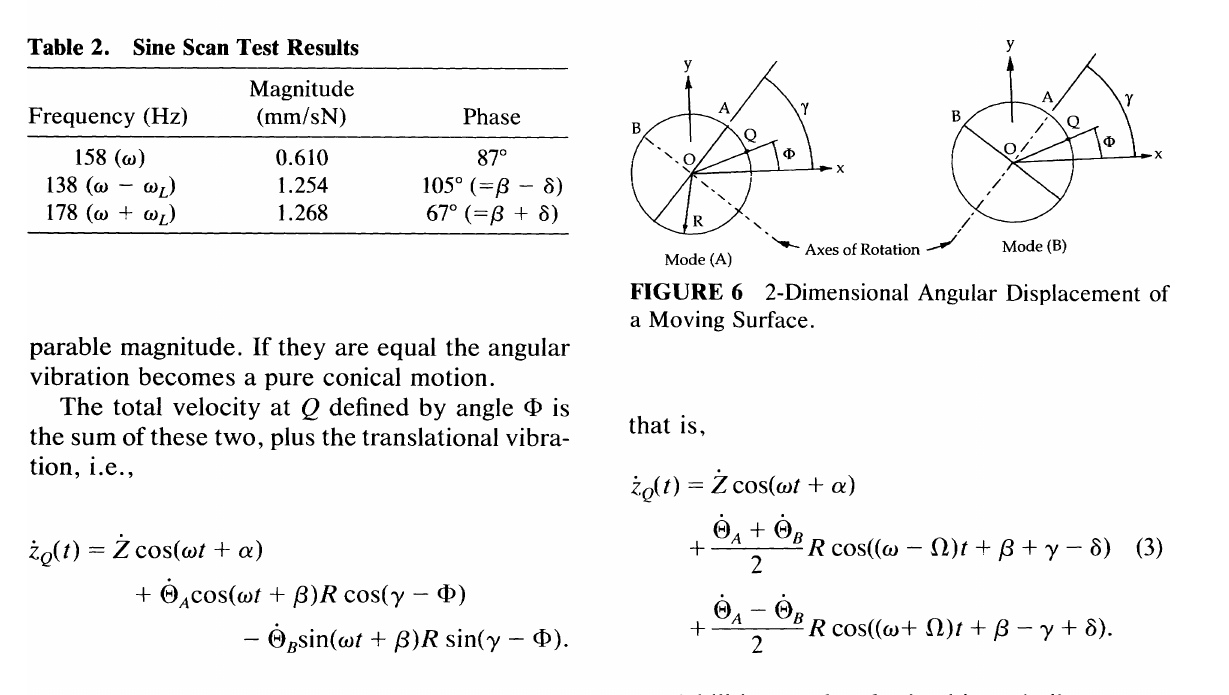
Table 2. Sine Scan Test Results